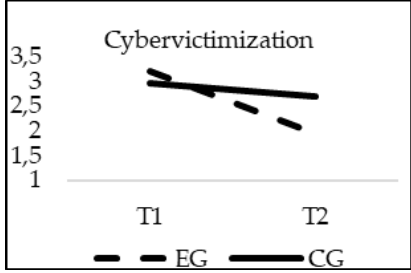
Figure 4. Interaction effects of group (EG-CG) and time (T1-T2) in Cyberbullying (E-Bullying Scale).